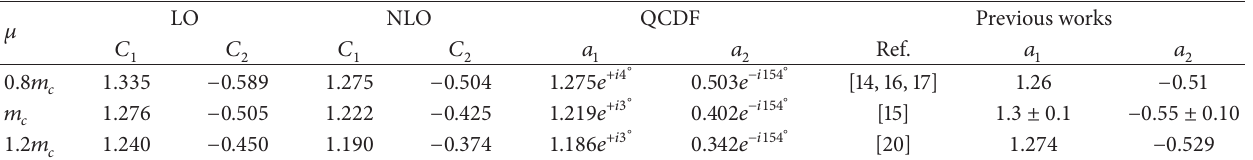
Table 2: Numerical values of the Wilson coefficients 𝐶 1,2 and parameters 𝑎 1,2 for 𝜂 𝑐 → 𝐷𝜋 decay with 𝑚 𝑐 = 1.275 GeV [12], where 𝑎 1,2 in [20] is used in the 𝐷 meson weak